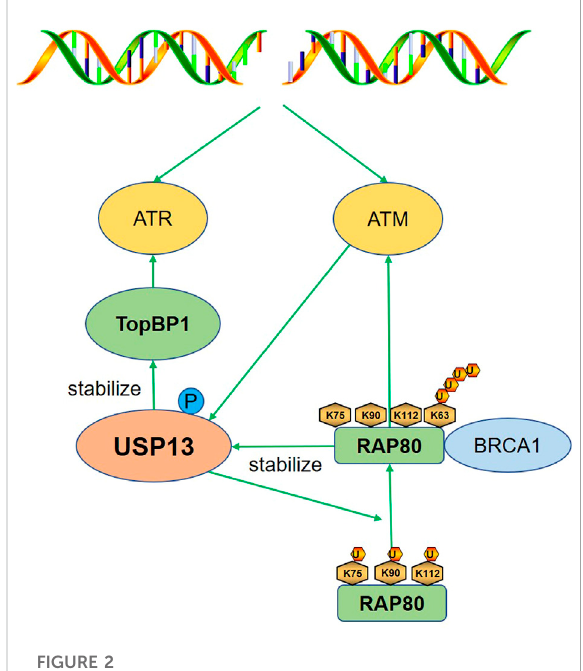
FIGURE 2 USP13 regulates DDR. After DNA damage, USP13 is phosphorylated and activated by ATM to deubiquitinate RAP80 (K75, K90, and K112), which promoted the binding of RAP80 with the K63-linked polyubiquitin chain and the subsequent recruitment of BRCA1, triggering proper DDR. TopBP1 is also stabilized to activate ATR in response to replication stress. Green arrow indicates